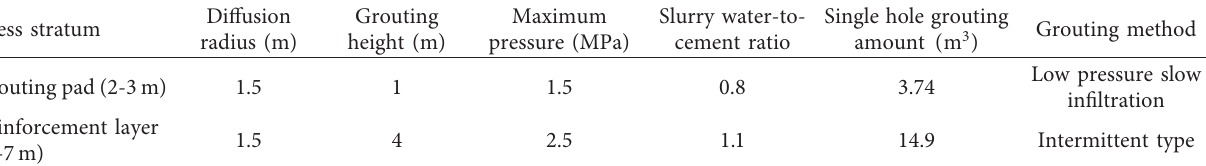
Table 7: Grouting parameters based on the comprehensive water-to-cement ratio.